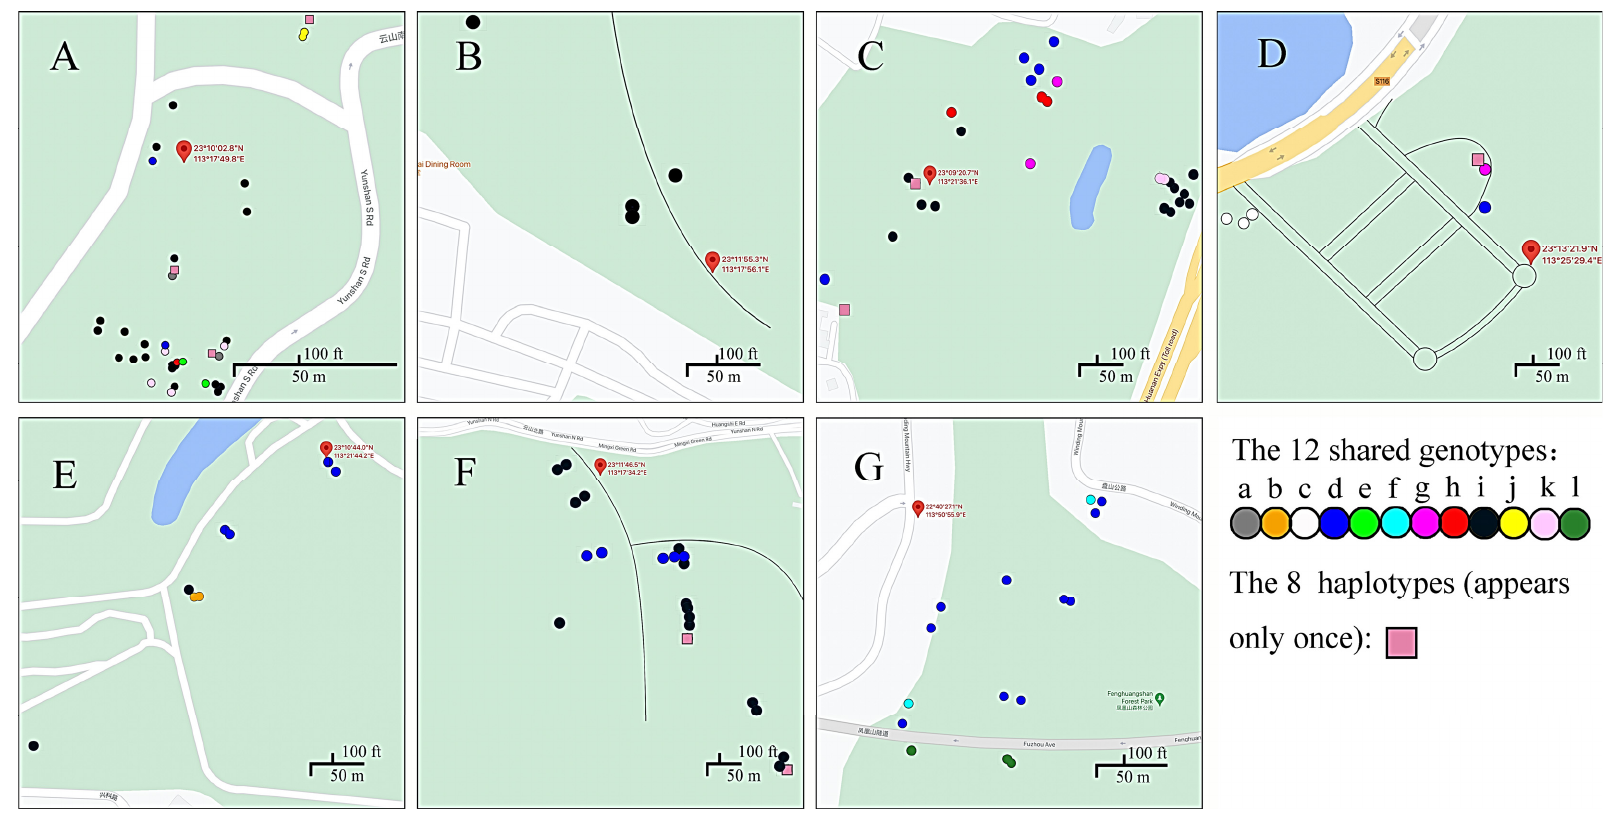
Figure 2. Distributions of multilocus genotypes within and among the seven collection sites. Sub-figures A to G illustrate the spatial distribution of individual fruiting bodies and their multilocus genotypes in site A to G. Filled circles of the color represent the same multilocus genotype: site A contains 36 fruiting bodies belonging to nine genotypes; site B contains four fruiting bodies belonging to one genotype; site C contains 27 fruiting bodies belonging to seven genotypes; site D contains six fruiting bodies belonging to four genotypes; site E contains eight fruiting bodies belonging to three genotypes; site F contains 22 fruiting bodies belonging to four genotypes; and site G contains 15 fruiting bodies belonging to three genotypes. The geographic location of sites A to G are shown in Table